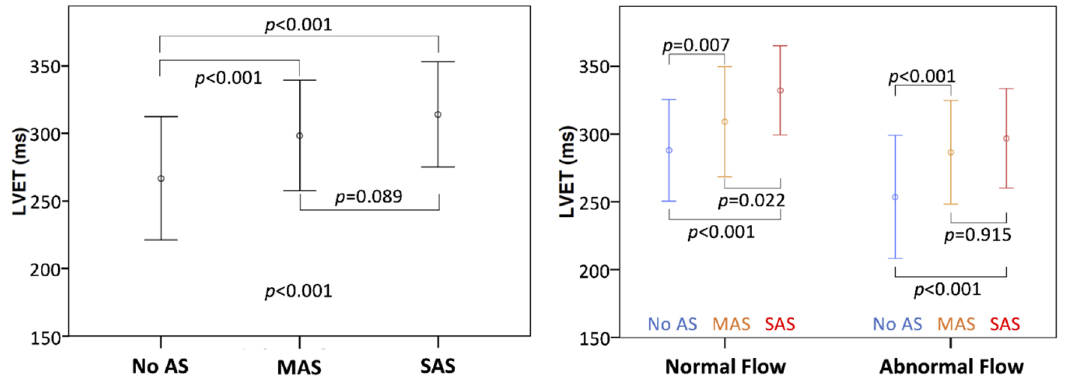
Figure 3. Mean left ventricular ejection time (LVET) according to aortic stenosis (AS) grading ( left ) and to flow status and AS grading ( right ). Abnormal flow is identified by stroke volume index ≤ 35 mL/m 2 or flow rate ≤ 210 mL/s. MAS, moderate AS; SAS, severe AS.